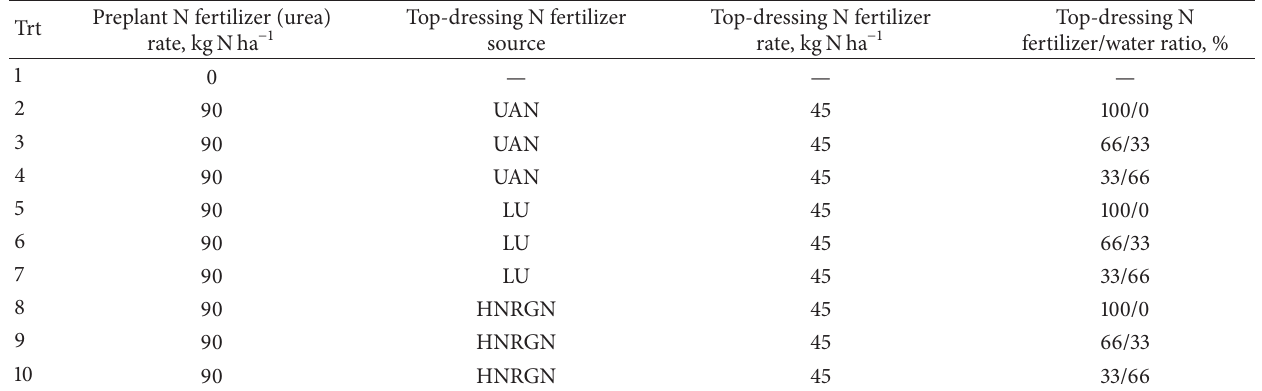
Table 1: Treatment structure, Choteau, Conrad, and Corvallis, 2012 and 2013.